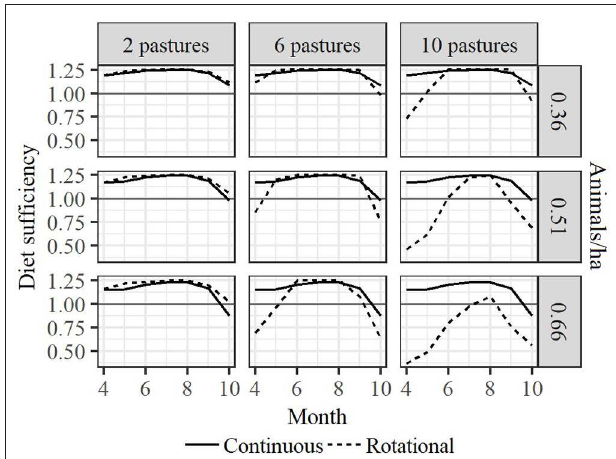
FIGURE 6 | Animal performance, as measured by diet sufficiency, in continuous (solid line) vs. rotational grazing (dashed line) simulations. All simulations were run for 5 years, but for clarity only the final 12 months are shown here. Intra-annual patterns were similar across all 5 years (see Supplemental Figure 6 for full results across all simulated